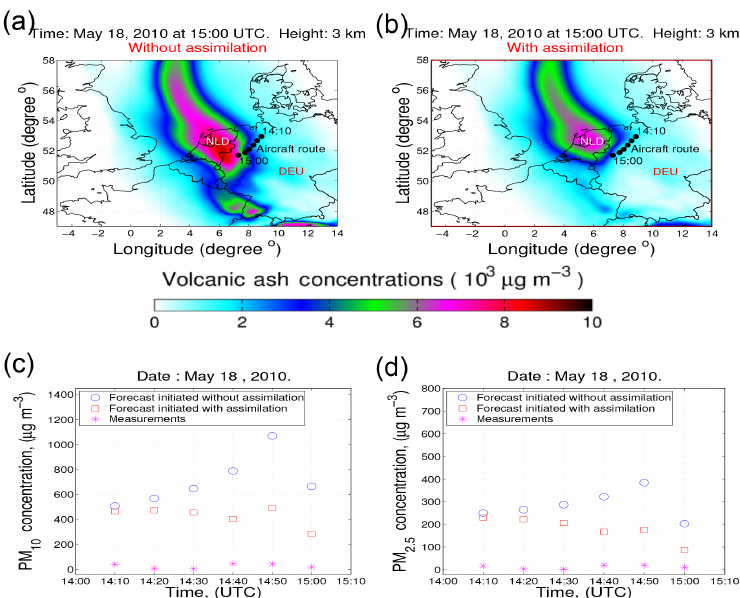
Figure 4. Forecast at 15:00UTC 18 May 2010 with different initial conditions for the volcanic ash state. (a) Forecast initiated with (Fig. 3b). (b) Forecast initiated with (Fig. 3d). (c) PM 10 concentration from 14:10 to 15:00UTC. (d) PM 2 . 5 concentration from 14:10 to